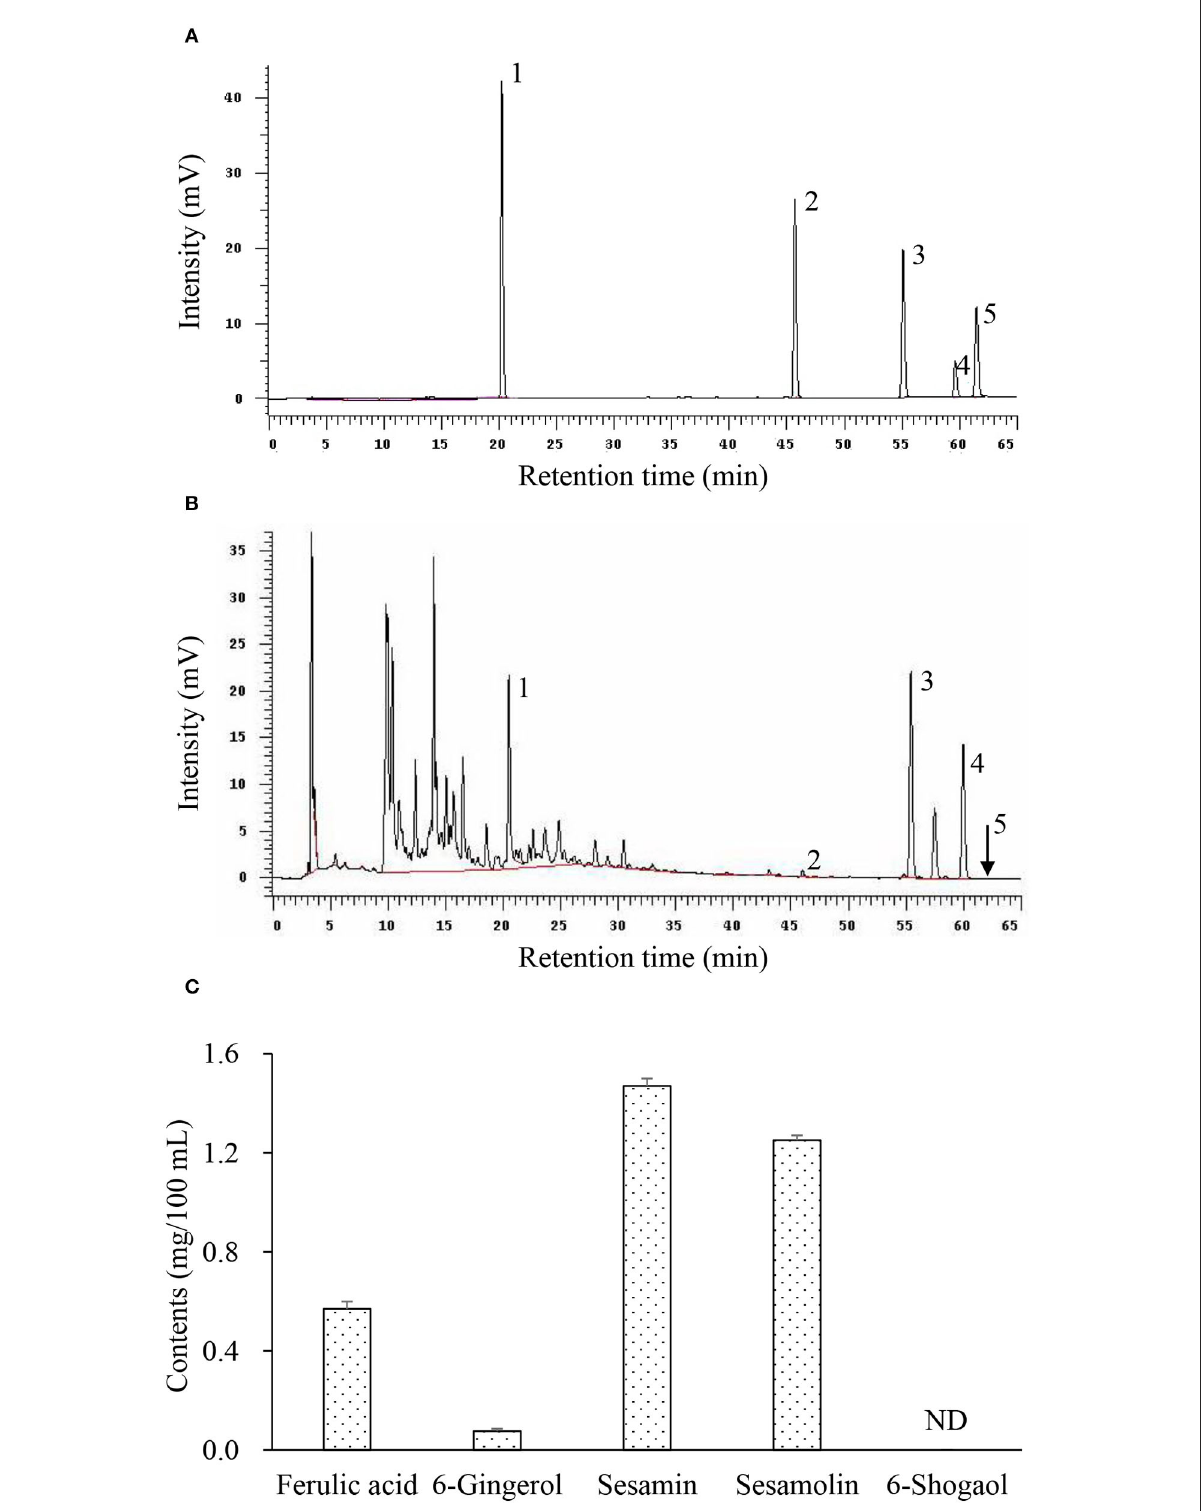
FIGURE1 Representative chromatograms of bioactive phytochemicals in herbal chicken essence (HCE) as determined by HPLC. (A) Standard references; (B) Herbal chicken essence; (C) Contents of bioactive phytochemicals. 1, Ferulic acid; 2, 6-Gingerol; 3, Sesamin; 4, Sesamolin; 5, 6-Shogaol; ND, Not detected. Values are expressed as means ± SD ( n =